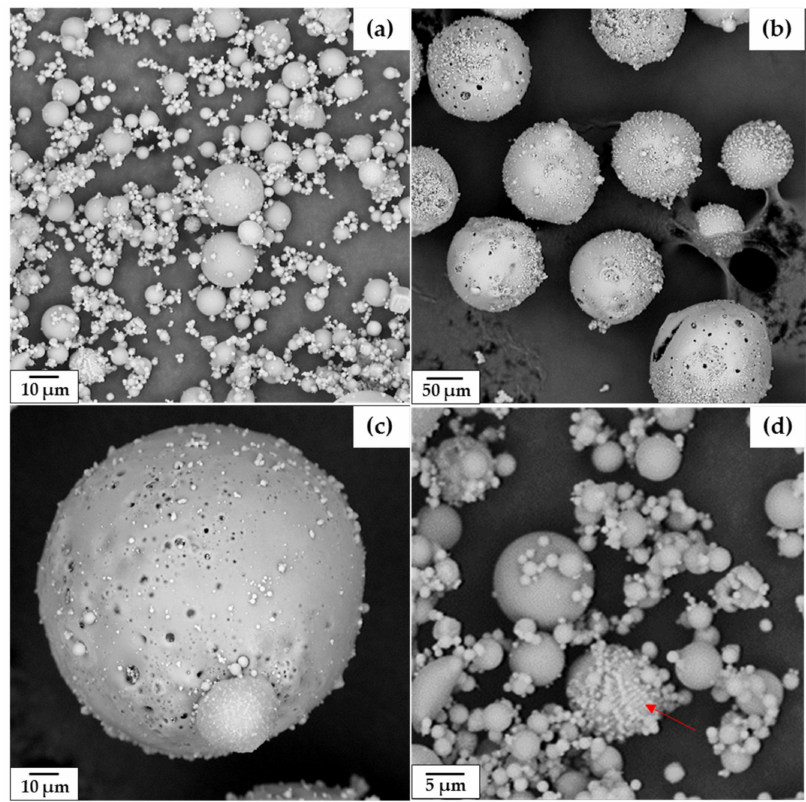
Figure 2. SEM image of ( a ) fly ash and ( b ) cenospheres collected by the sink-float method using 1:10 fly ash-to-medium ratio, 2 h soaking period. ( c ) The zoomed-in image of a cenosphere particle. ( d ) The appearance of iron surface condensation on the ash